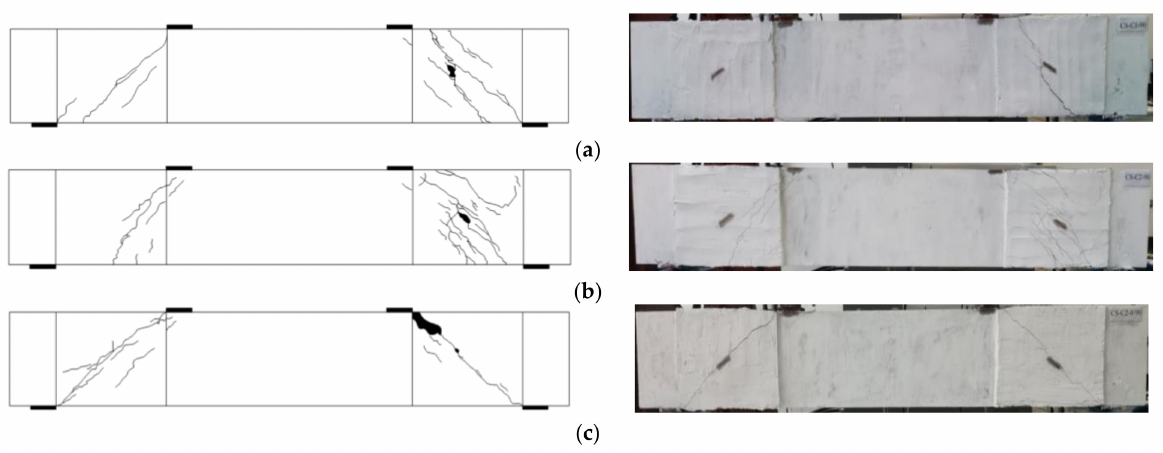
Figure 8. Crack pattern at failure of specimens in group B: ( a ) ST-C1-90; ( b ) ST-C2-90; ( c )